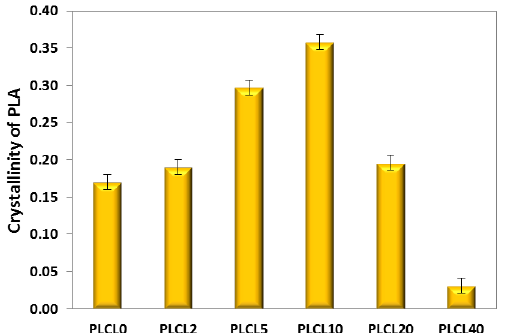
Figure 7. Crystallinity of electrospun bicomponent fibres with PGSu additive: PLCL2, PLCL5,